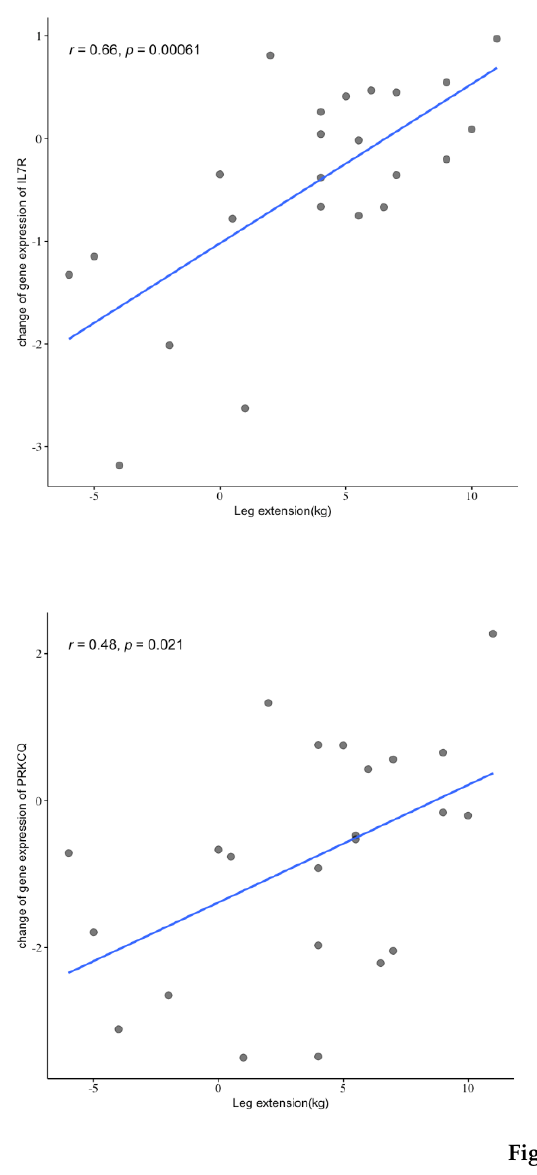
Figure 2. Figure showing the correlation between changes in gene expression and leg extensions in combined